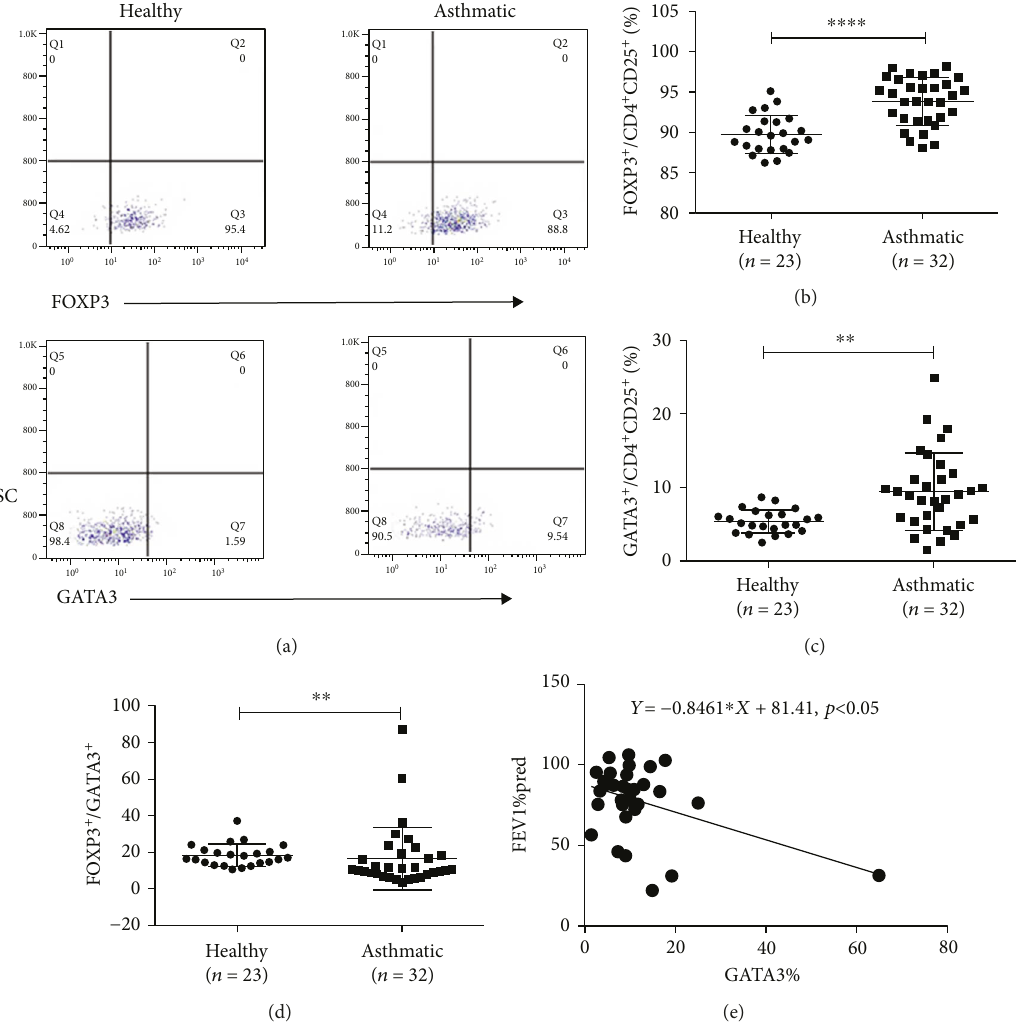
Figure 5: Enhancing expression of speci fi c transcription factors, especially GATA3 in Treg cells from asthmatic patients. (a) Representative examples of fl ow cytometry analysis of FOXP3 and GATA3 expression by CD4 + CD25 + Treg cells in healthy and asthmatic subjects. (b, c). Frequencies of FOXP3 and GATA3 expressed in healthy and asthmatic subjects. (d) The ratio of FOXP3 and GATA3 expressed in healthy and asthmatic subjects. (e) The correlation of the percentage of CD4 + CD25 + GATA3 + Treg cells with FEV1%pred. The graph shows means ± sem . ∗ p < 0 05 , ∗∗ p < 0 01 , and ∗∗∗∗ p < 0 0001 . NS: no signi fi